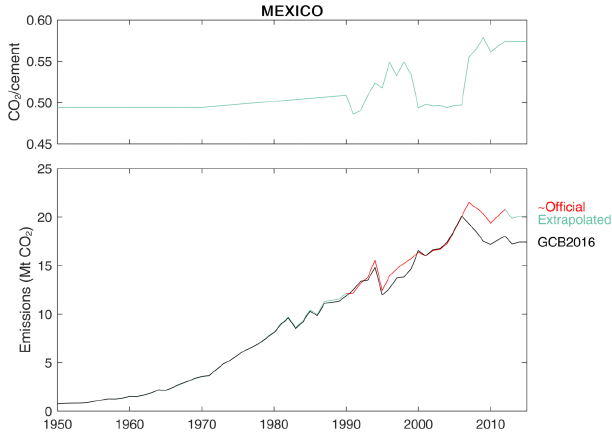
Figure D24. Revised cement emissions for